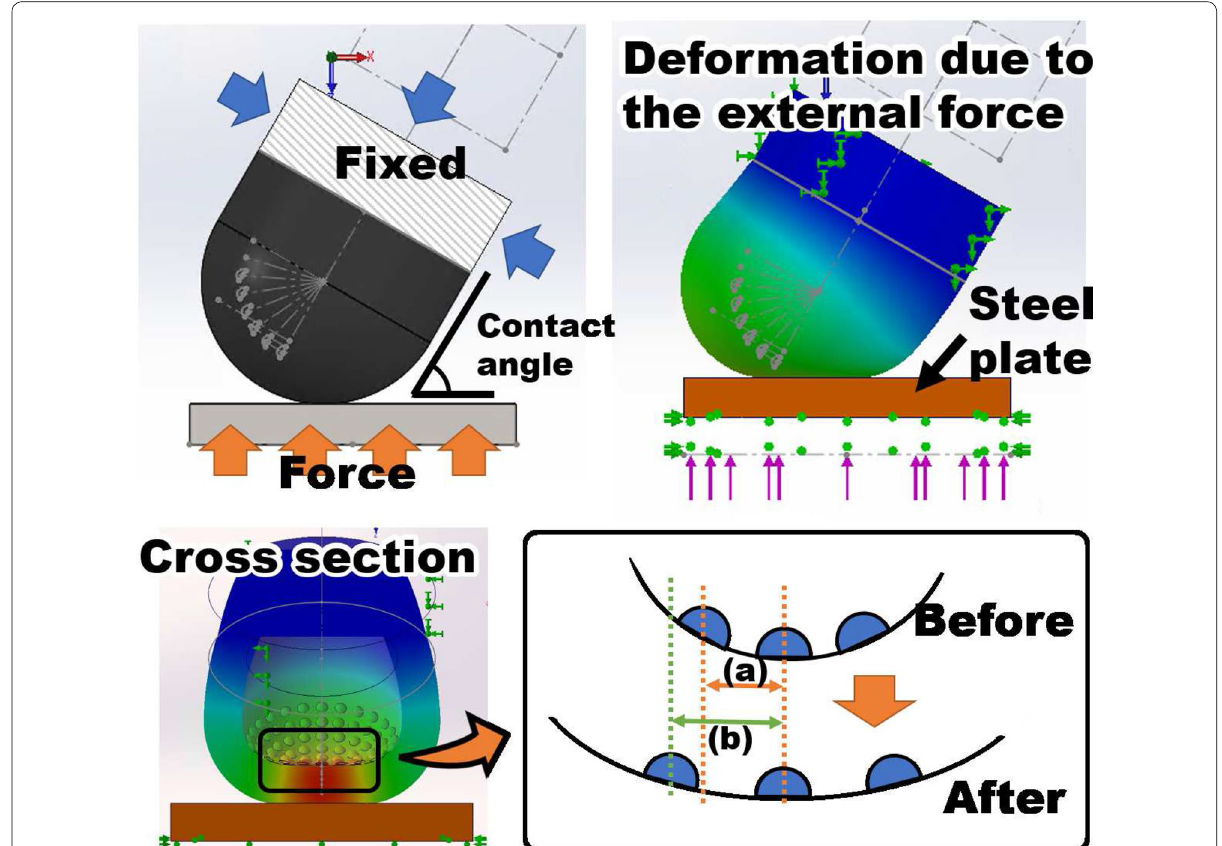
R 15 × 15 where H ( q ) ∈ denotes an inertia matrix of all the R 3 × 3 R t × 3 fingers; M ∈ is the mass of the object; I ∈ is = [ q . . . , q . . . , 11 , 15 q 21 , the inertia tensor of the object; q q 25 q 31 , . . . , q 35 ] T ∈ R 15 stands for the joint angle vector R 15 R 15 for all fingers; ˙ q ∈ and ¨ q ∈ are the joint angular R 3 velocity and acceleration vector, respectively; x ∈ , ˙ x ∈ R 3 , and ¨ x ∈ R 3 are the position, velocity, and acceler- Table 2 Distance of both side point markers in the case where the static external force is applied to the different positions on the fingertip and the ratio between the distance of before and after contacts: the contact angle is defined in Fig. 8b Distance Distance Ratio after/ before contact after contact before Fig. 11a Fig. 11b Fig. 11b/a (mm) (mm) Contact angle 90 ◦ 7.69 Contact angle 75 ◦ 8.65 Contact angle 45 ◦ 8.09 Contact angle 30 ◦